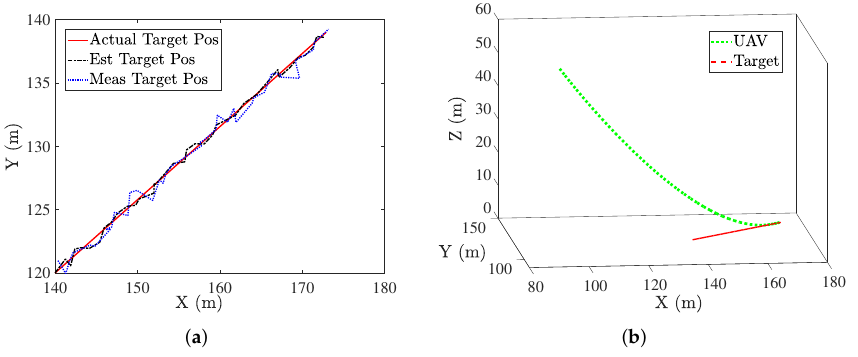
Figure 9. ( a ) Kalman filter performance for estimating target information ( b ) Trajectory followed by UAV when using estimated target